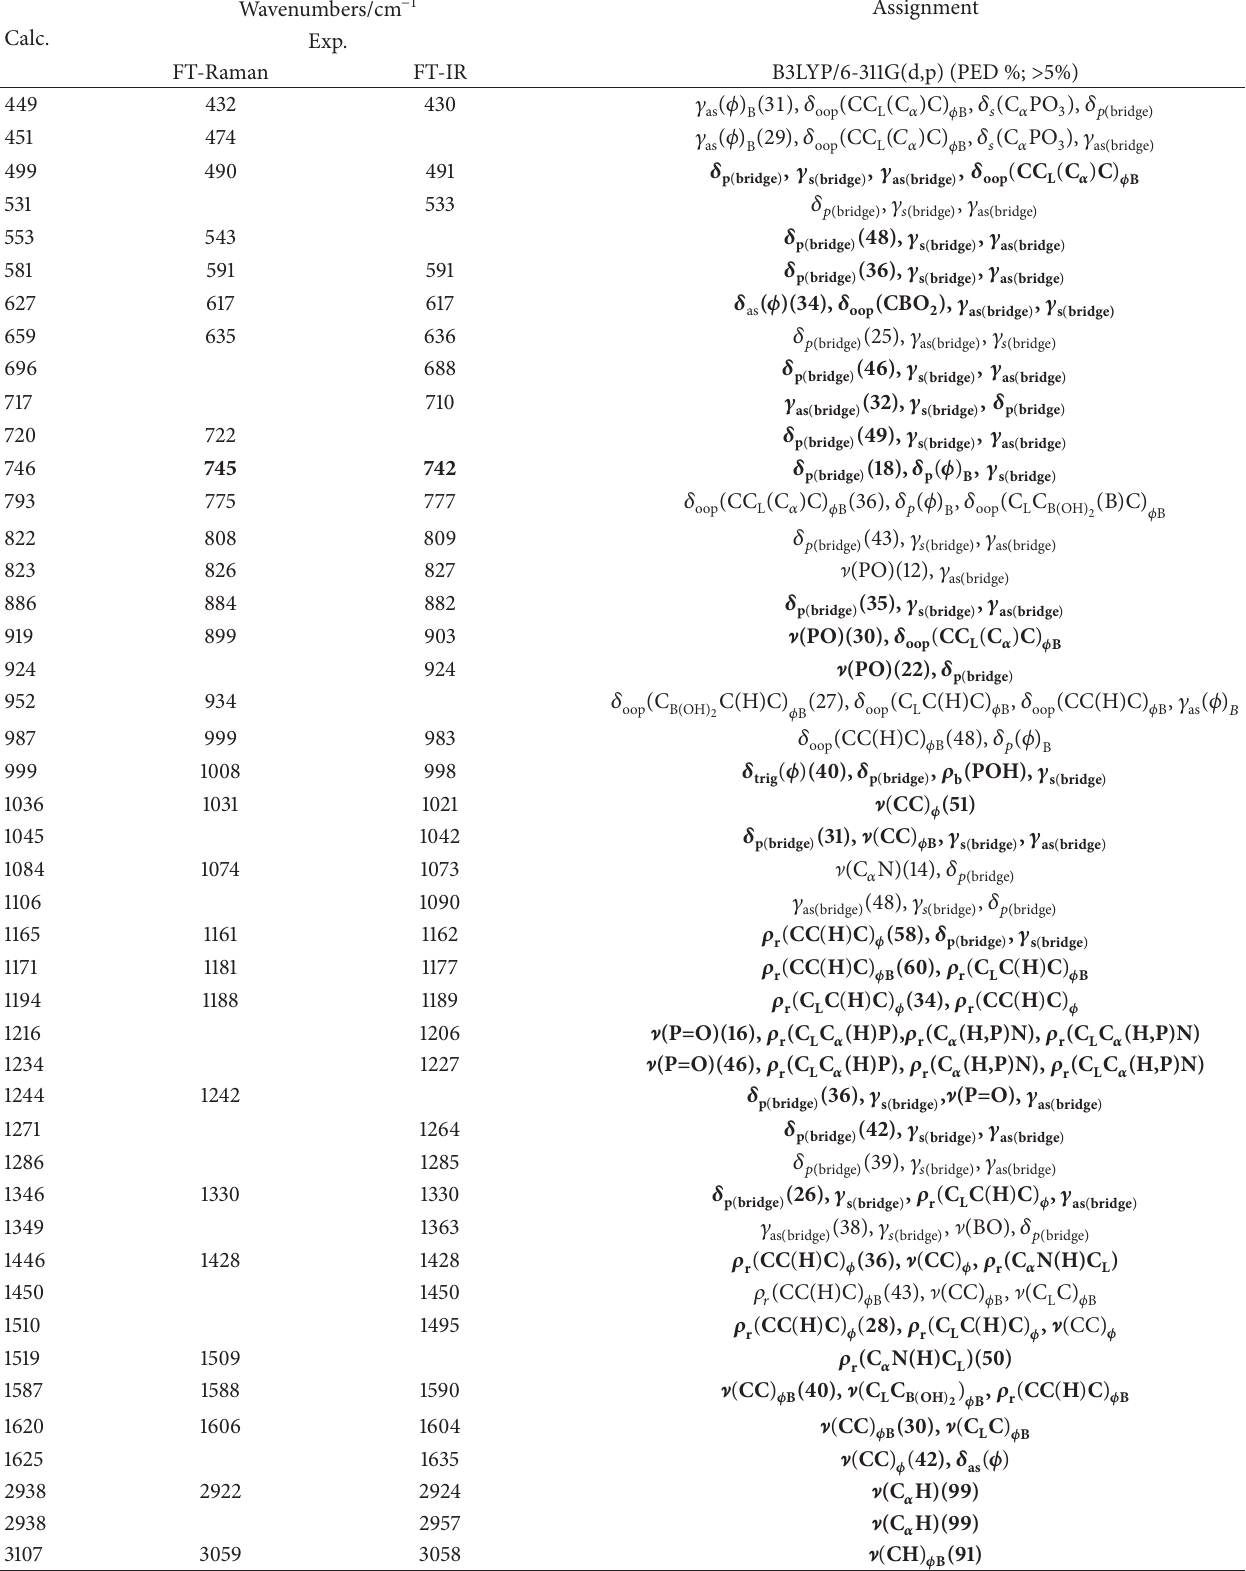
Table 2: The calculated wavenumbers and potential energy distribution (PED, %) for the FT-Raman and FT-IR spectra of [PhN-(2- )- 𝑅 -Me]PO 3 H 2 a . PhB(OH) 2